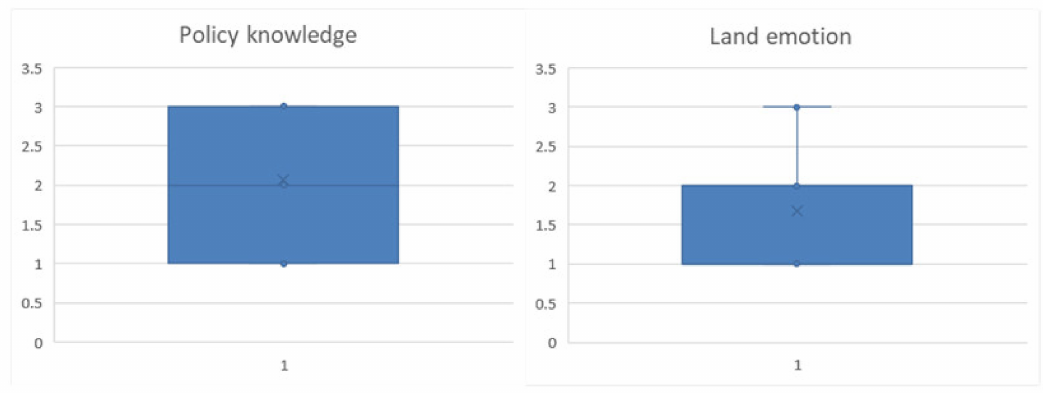
Figure 6. Boxplots of cognitive characteristics descriptive